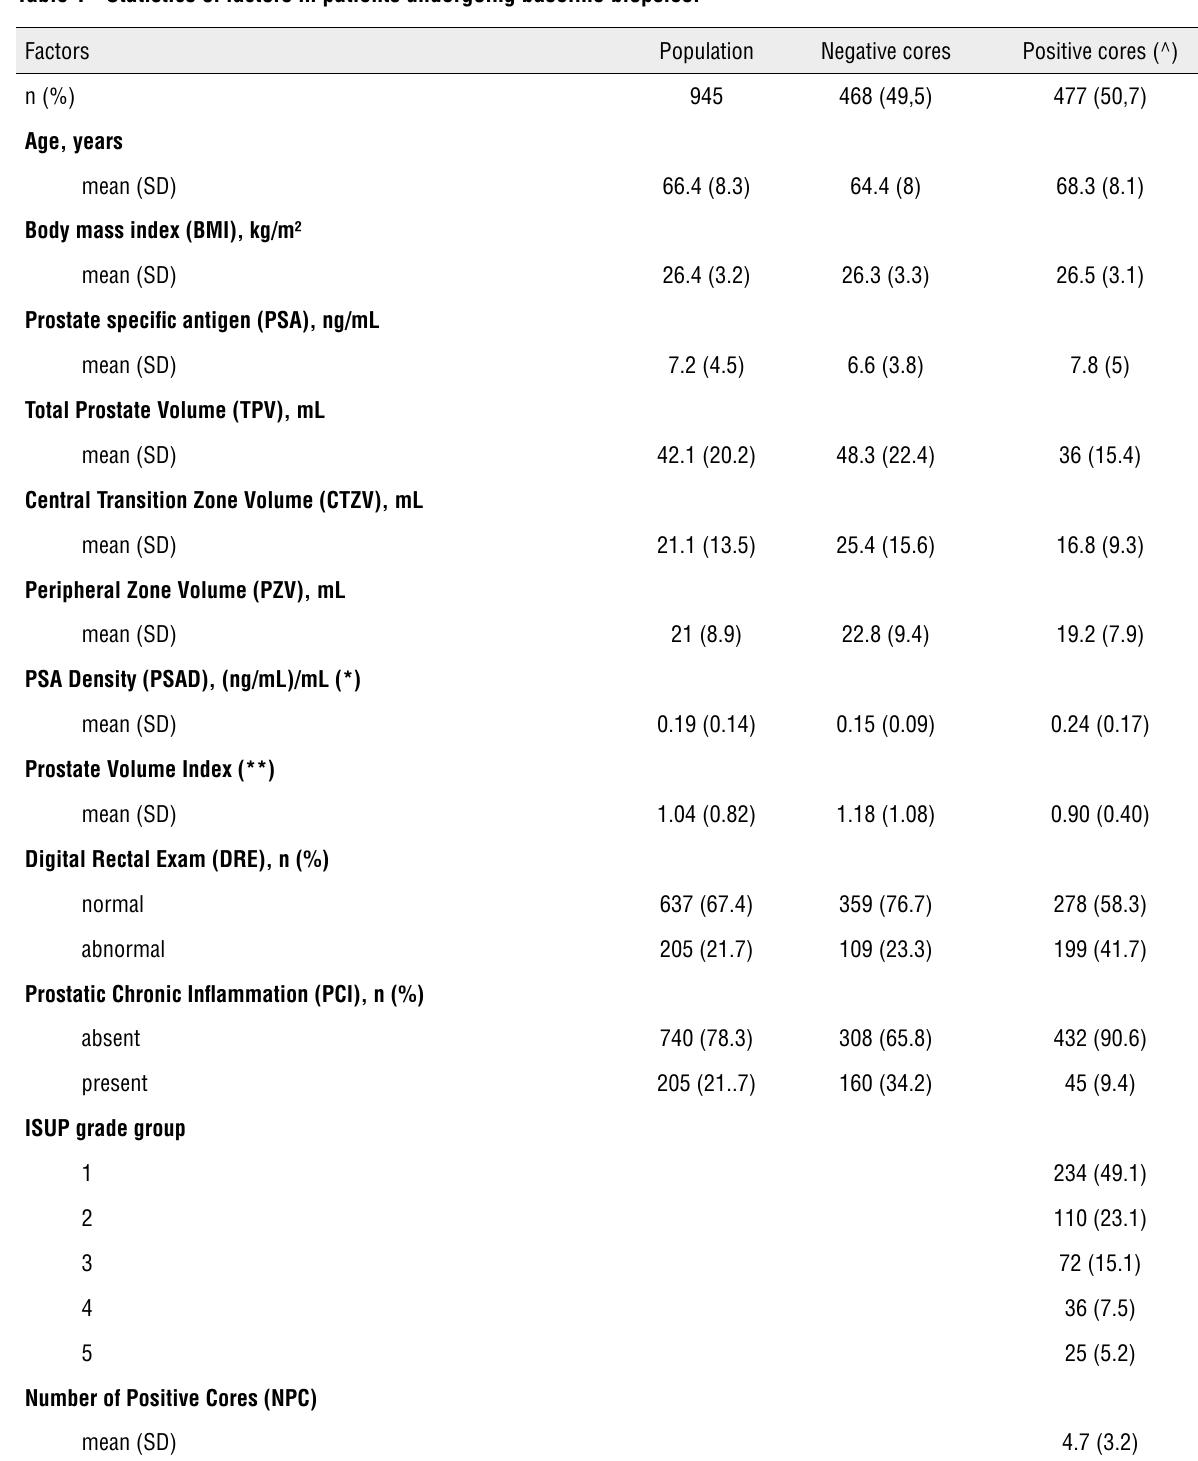
Table 1 - Statistics of factors in patients undergoing baseline